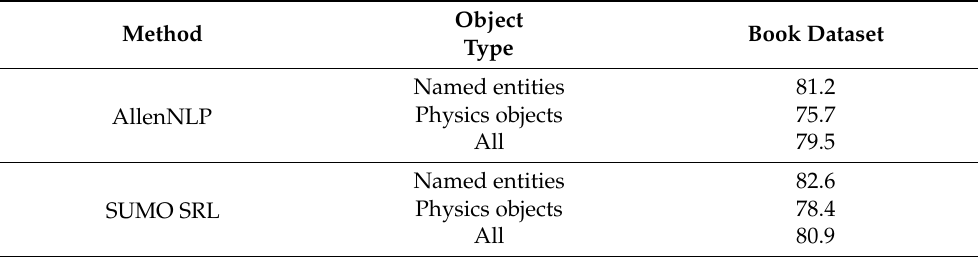
Table 7. Coreference and object identification